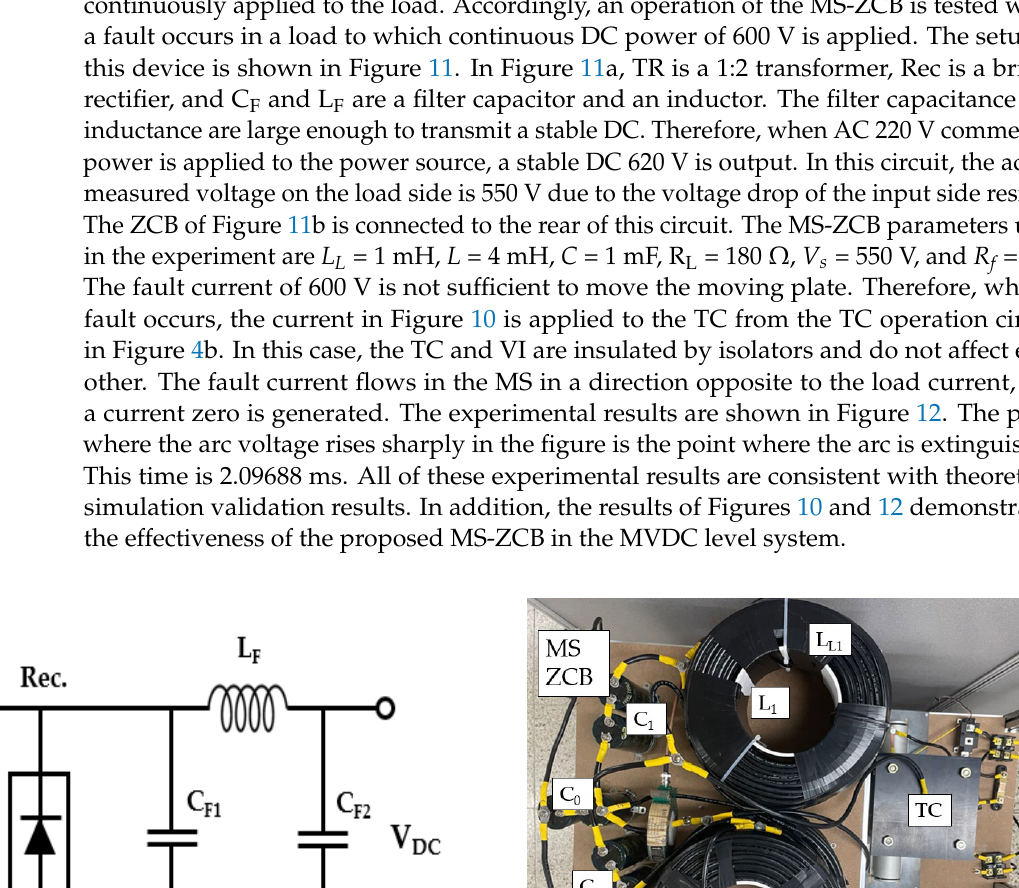
Figure 10. Experimental results: discharge current and VI contact voltage. C S = 17.25 mF, L S = 26 µH, R TC = 0.2 Ω, L TC = 4.4 µH ( a ) full screen; ( b ) zoom-in screen.